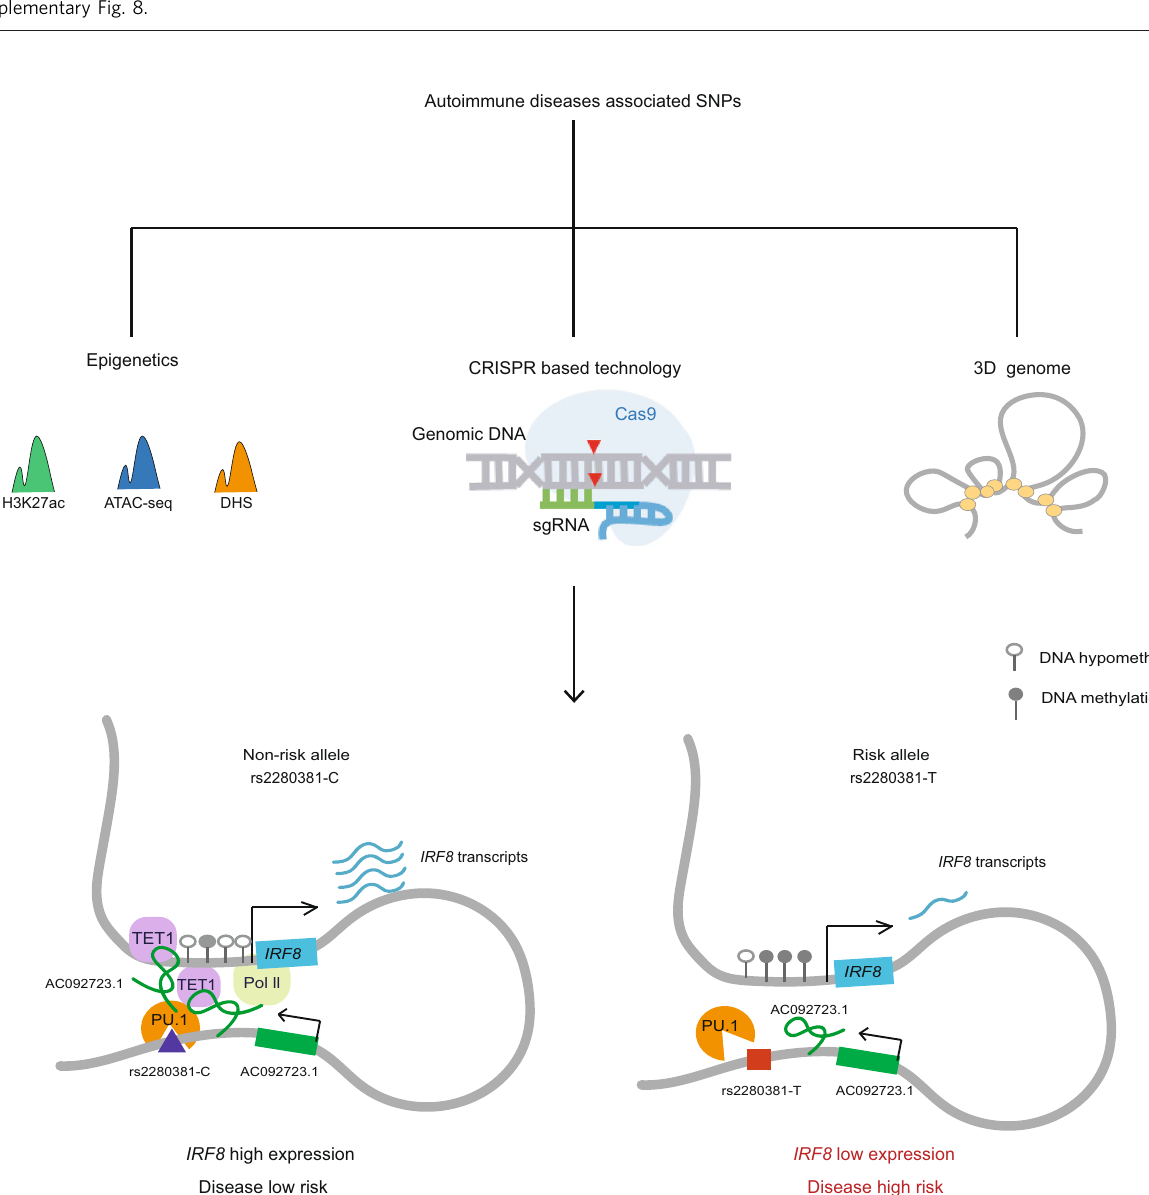
Fig. 5 rs2280381 alleles affect H3K27ac and PU.1 binding to fi ne-tune the expression of AC092723.1 and IRF8 . A Work fl ow for the generation of isogenic cell clones with the Prime editing technology. RT Reverse Transcriptase. B , C The rs2280381 C allele leads to higher expression of AC092723.1 and IRF8 compared to the T allele. ( n = 6, biologically independent samples). D Genotype-dependent binding of H3K27ac for rs2280381. Results with MARIO ARS value >0.4 across ChIP-seq datasets are included. The X -axis indicates the preferred allele, along with a value indicating the strength of the allelic behavior, calculated as one minus the ratio of the weak to strong read counts (e.g., 0.5 indicates the strong allele has twice the reads of the weak allele). ARS allelic reproducibility score. E The genomic region containing the non-risk allele C exhibits increased chromatin accessibility compared to the risk allele T, as determined by AS-FAIRE-qPCR in the rs2280381 heterozygous U-937 cell clone. ( n = 3, biologically independent experiments). F ChIP-seq in monocyte and macrophage indicates the PU.1 binds to rs2280381 site. Relative expression of PU.1 ( G ), IRF8 ( H ) and AC092723.1 ( I ) after PU.1 siRNA- mediated knockdown, as measured by RT-qPCR in primary monocytes ( n = 3, biologically independent experiments). J PU.1 prefers binding to the rs2280381 C non-risk allele, as analyzed by MARIO methods using the PU.1 ChIP-seq data in primary monocytes or macrophage provided by ADASTRA database. Data are represented as mean ± SEM, and p values are calculated using an unpaired two-tailed Student ’ s t test. ns not signi fi cant. See also Supplementary Fig. 8.